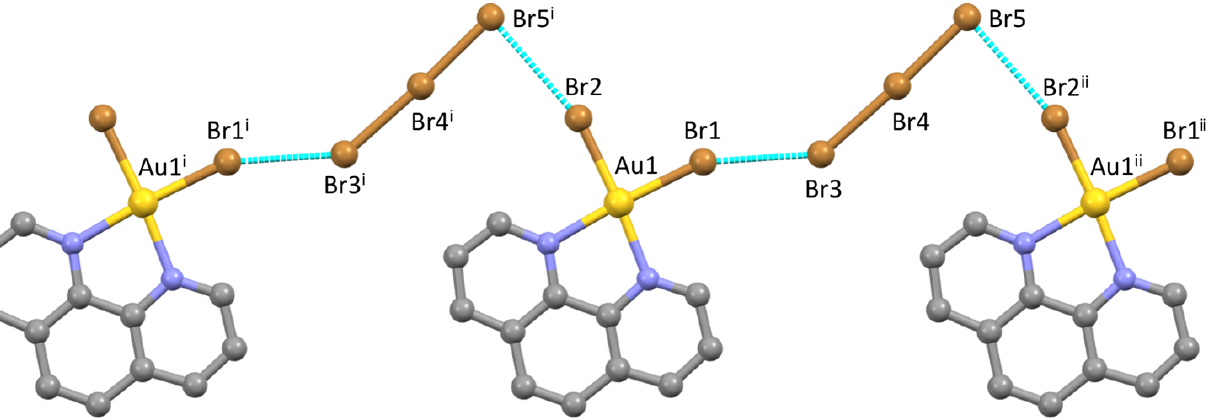
Figure 2. Au–Br···Br XB interactions resulting in a zig-zag infinite chain running along the c axis. i = x, y, − 1 + z; ii = x, y, 1 + z. Hydrogen atoms were omitted for clarity.